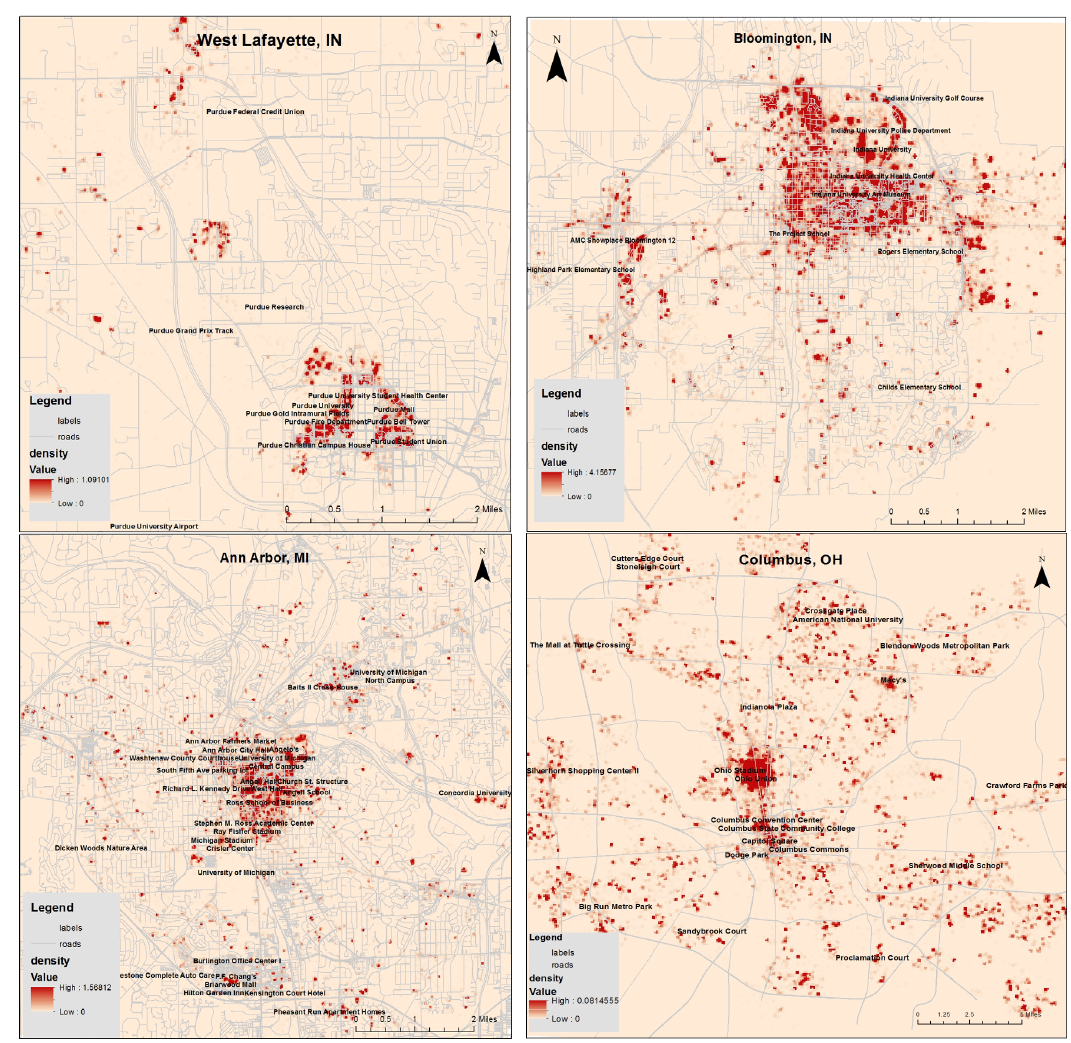
Figure 1. Maps of the fours study areas and their tweet densities (tweet counts/square meters).